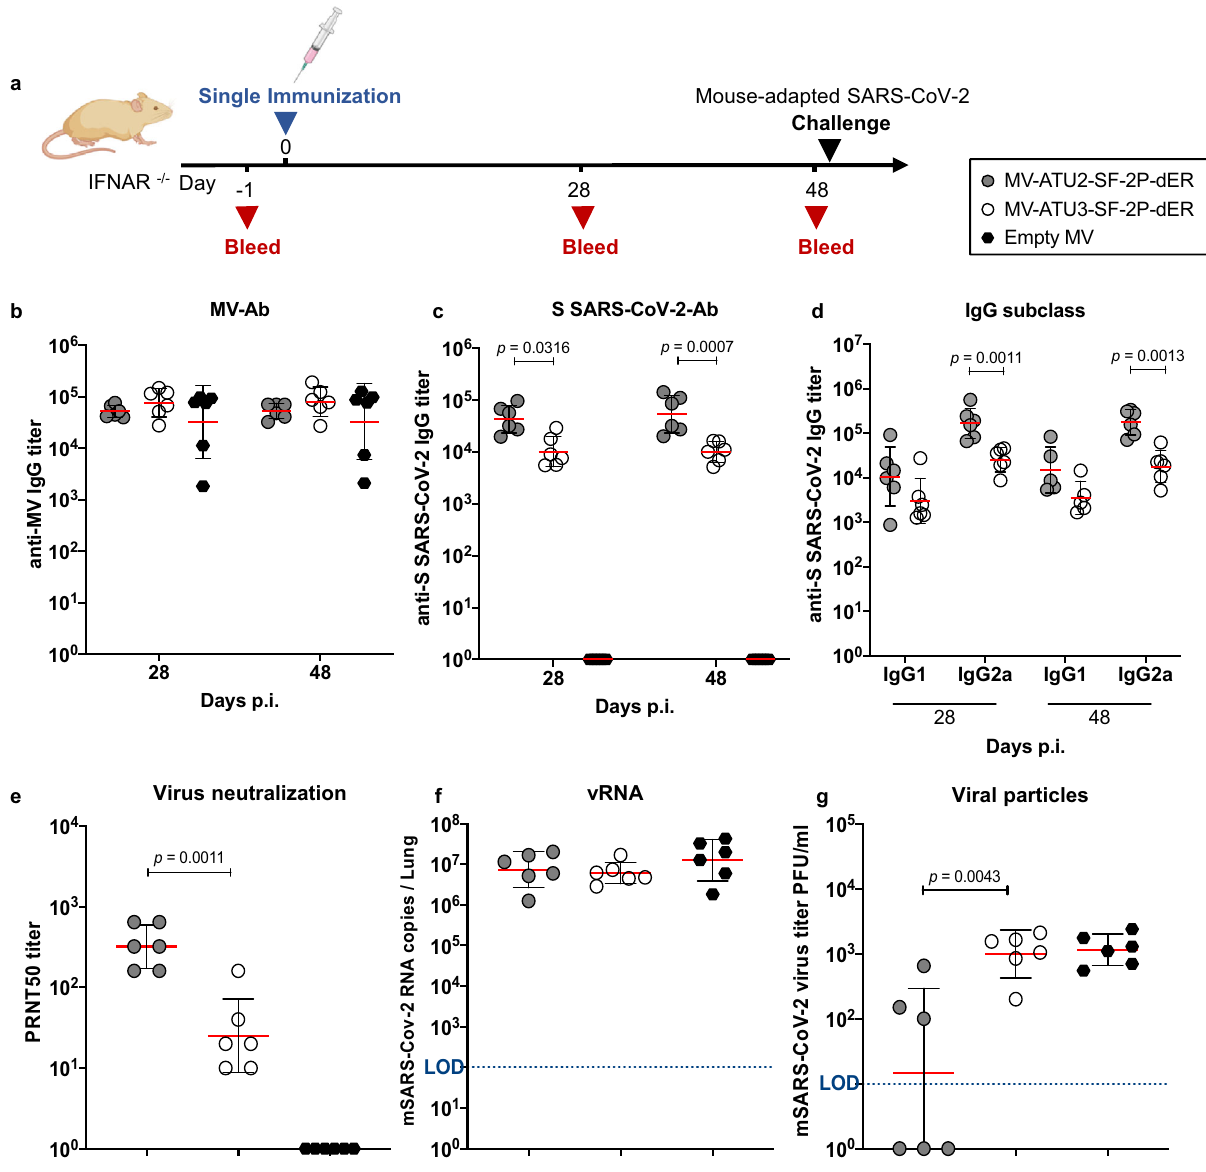
Fig. 7 Immune responses and protection after a single immunization. a Immunization and challenge schedule for IFNAR − / − mice ( n = 6). Animals were immunized interperitoneally on day 0. Sera were collected at days 24 and 48. Animals were challenged on day 48 by intranasal inoculation of mouse- adapted SARS-CoV-2 virus (MACo3) at 1.5 × 10 5 PFU. Sera were assessed for levels of speci fi c antibodies to b MV and c S-SARS-CoV-2 protein. d Neutralizing antibody responses against SARS-CoV-2 virus, expressed as 50% plaque reduction neutralization test (PRNT 50 ) titers. e SARS-CoV-2 viral RNA copies detected by RT-qPCR in homogenized lungs of challenged animals, calculated as copies/lung. f Titer of infectious viral particles recovered from the homogenized lung of the immunized animals expressed as PFU/lung. Dotted blue line indicates the limit of detection (LOD). Data are represented as geometric means with line and error bars indicating ±geometric SD. Statistical signi fi cance was determined by b – d two-way ANOVA with Tukey ’ s multiple comparisons test, e – g Kruskal – Wallis one-way ANOVA test with Dunn ’ s multiple comparison